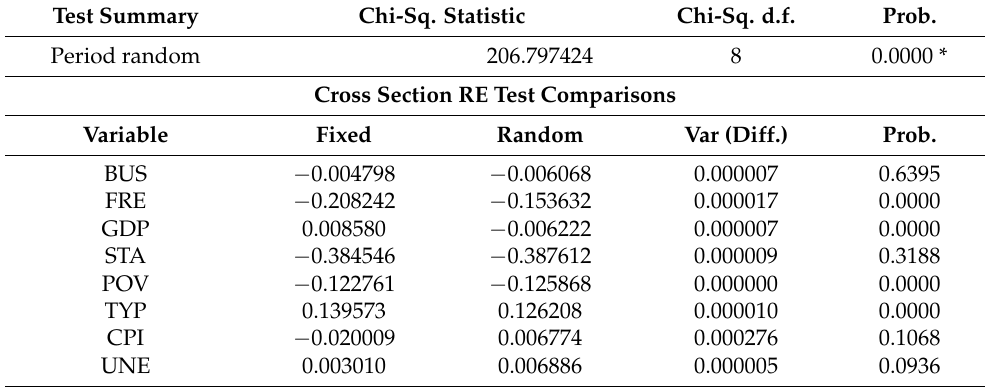
Table 6. Correlated—cross period (time) RE Hausman test.